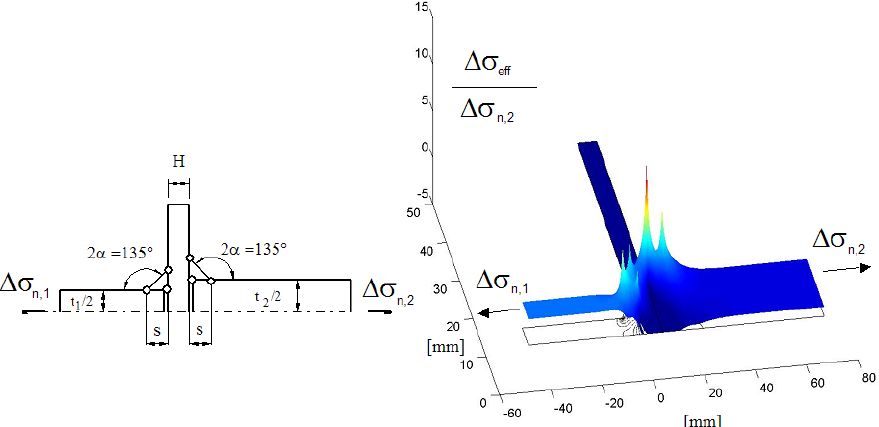
Figura 2: Tipica soluzione in termini di tensione efficace di una giunzione piana a cordone portante.